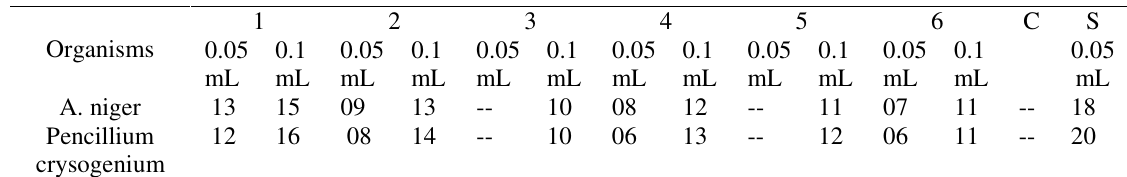
Table 4. Antifungal activity of chalcones